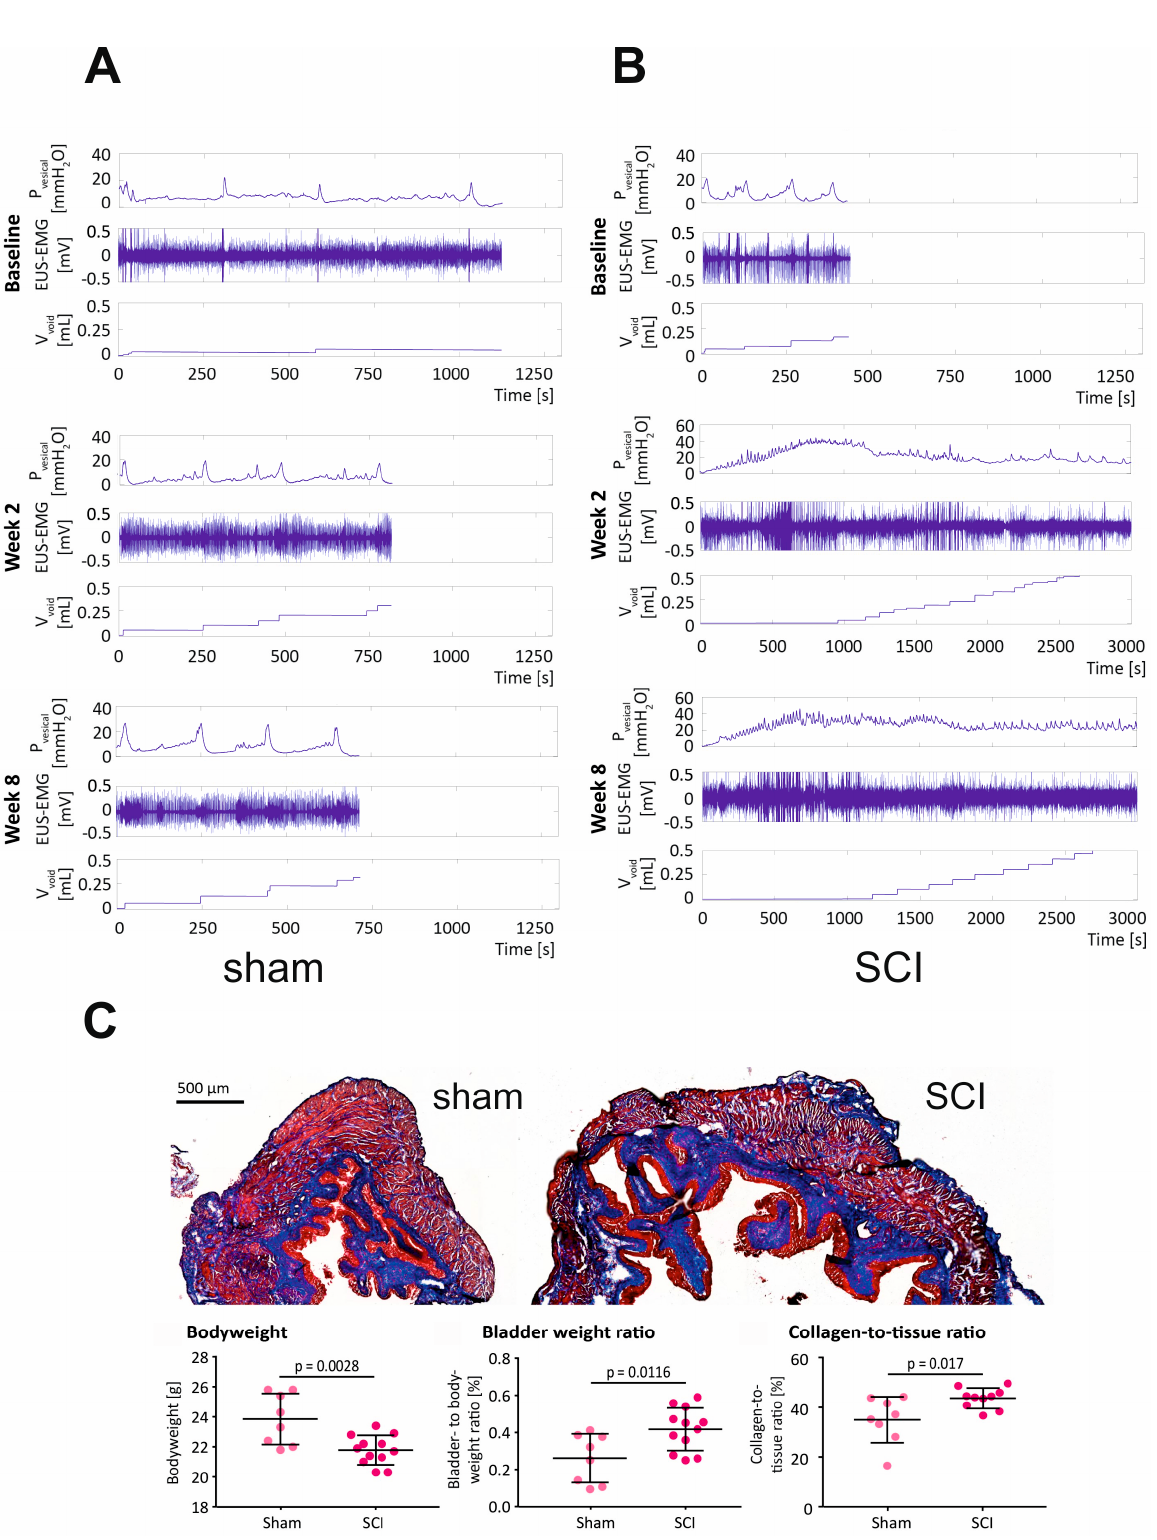
Figure 2. Functional and morphological alterations in the bladders of SCI mice. Representative UDI and EUS-EMG recordings in sham ( A ) and SCI ( B ) mice before injury (baseline) and at 2 and 8 weeks. ( C ) Bladder morphology was evaluated by Masson’s trichrome staining, bladder ‐ to ‐ bodyweight ratio, and % of collagen in the bladder wall were calculated.